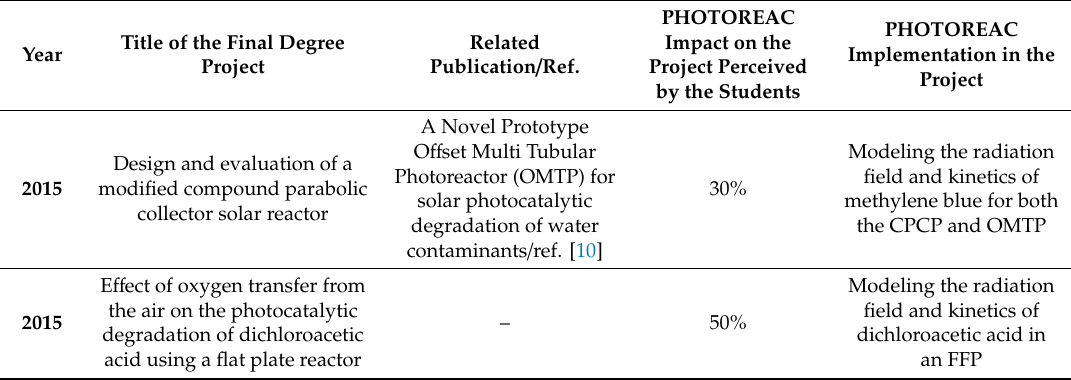
Table 4. PHOTOREAC impact on final degree projects in chemical